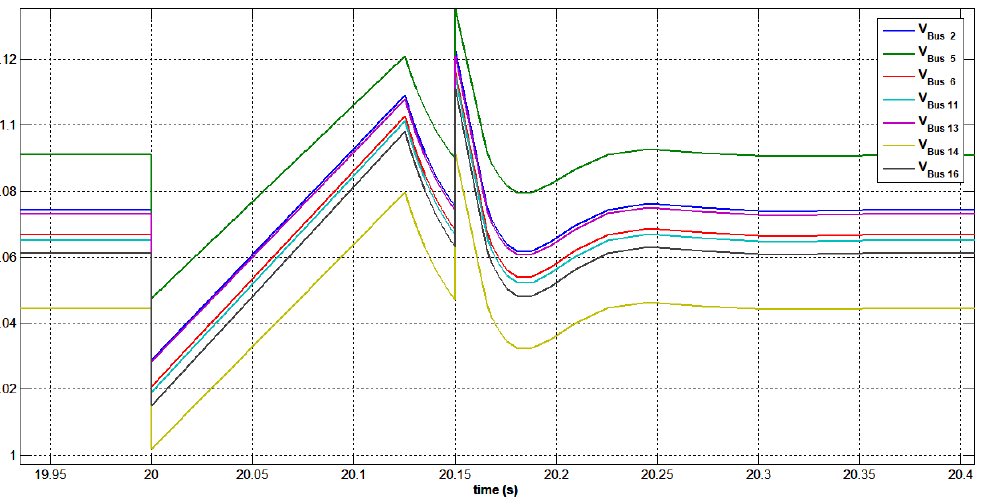
Figure 45. Voltage variation at buses 2, 5, 6, 11, 13, 14, and 16 under a three-phase short circuit at bus 15 with STATCOM.